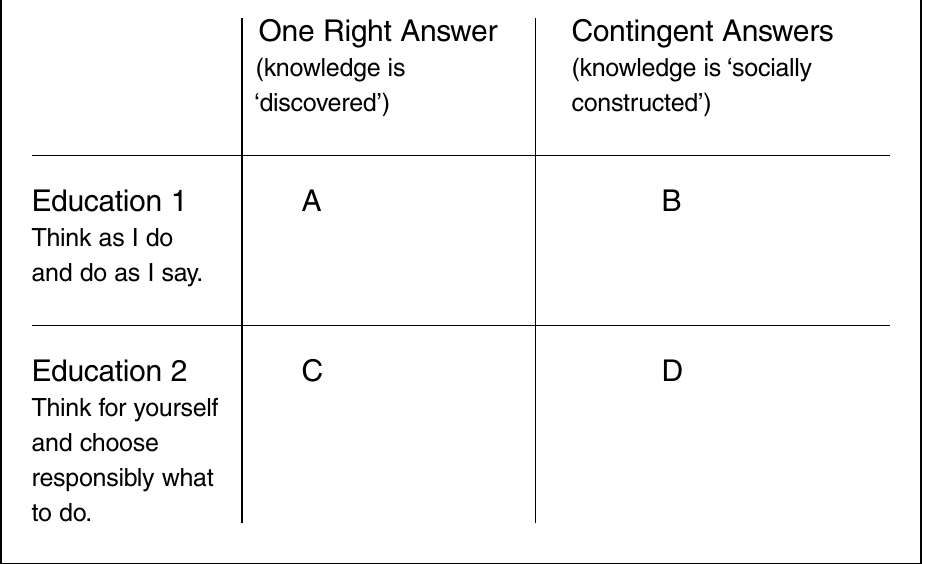
Figure 1: One of the pedagogical tools for inquiry (Andreotti and Souza, 2008:7) used in the project ‘Thinking Together’. This tool invited participants to analyse the possibilities and limitations of each type of education (A, B, C and D) in terms of pedagogical strategies, the construction of subjectivities and relationships to